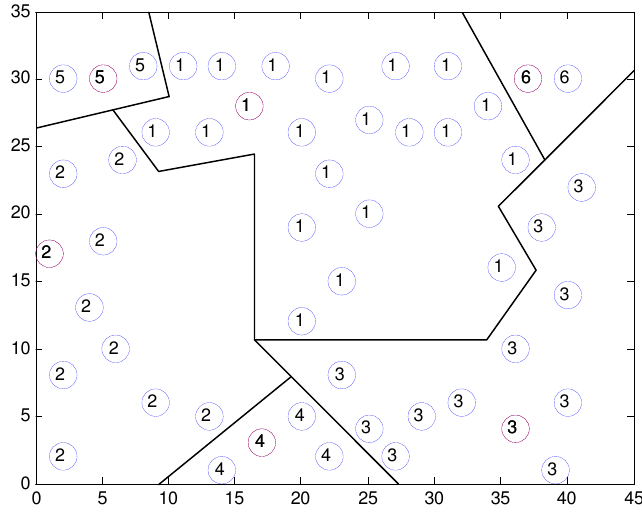
Figure 1. A clustering map is produced by implementing the Algorithm